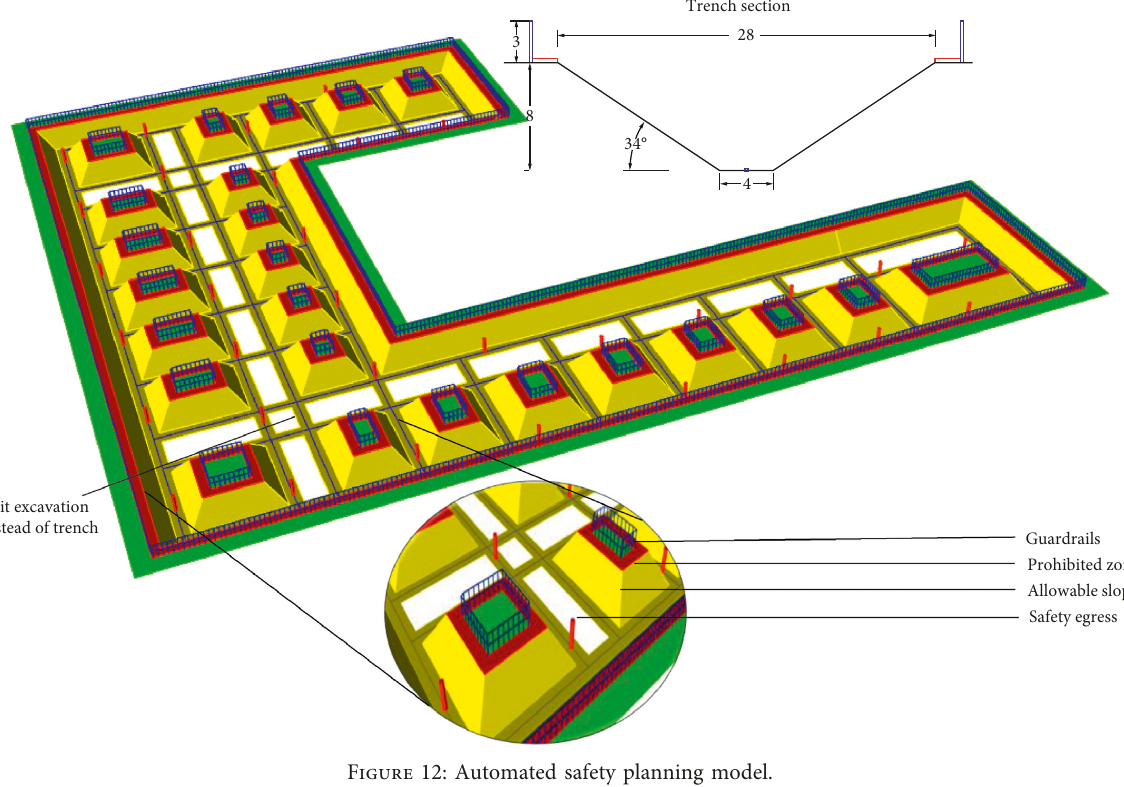
Figure 12: Automated safety planning model.